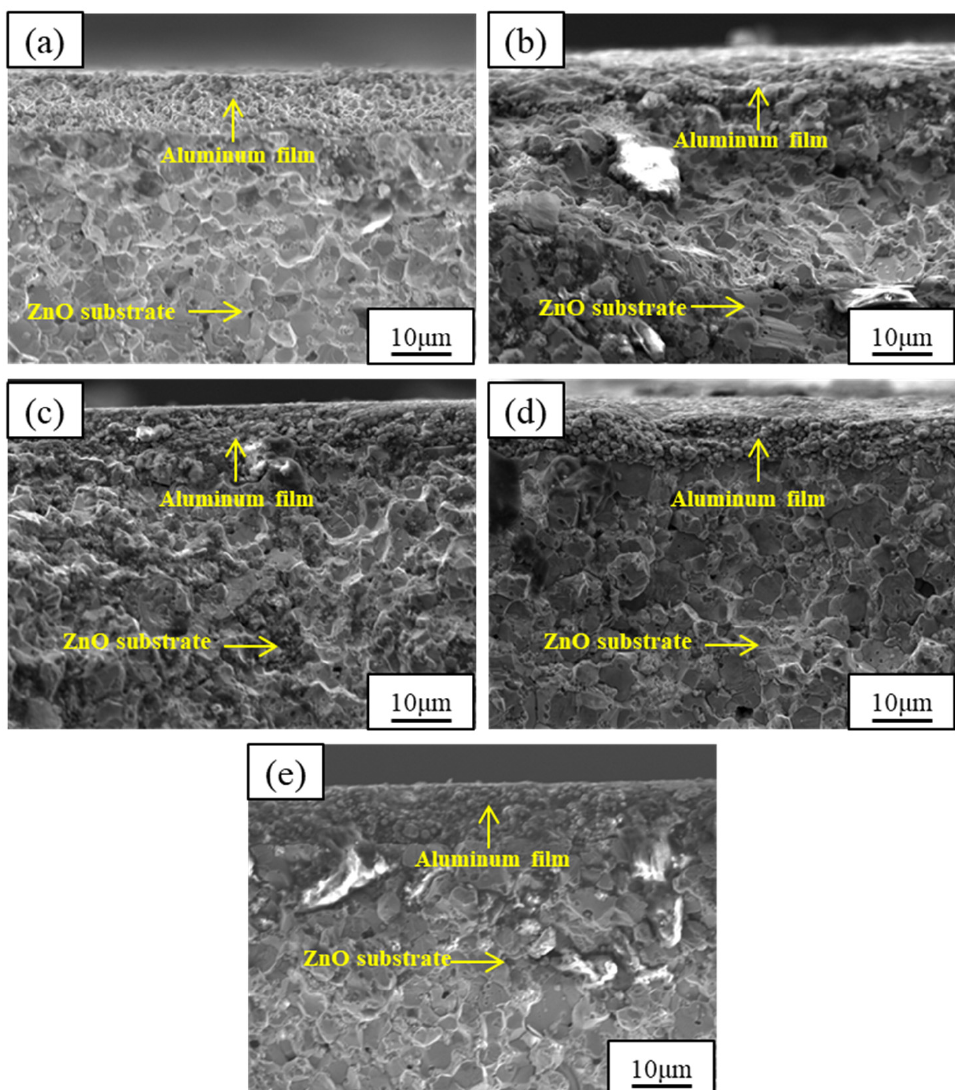
Figure 11. The cross-sectional SEM photographs of aluminum electrode sections with different contents of sodium carbonate added. ( a ): 0%, ( b ): 3%, ( c ): 4%, ( d ): 5%, ( e ): 6%.